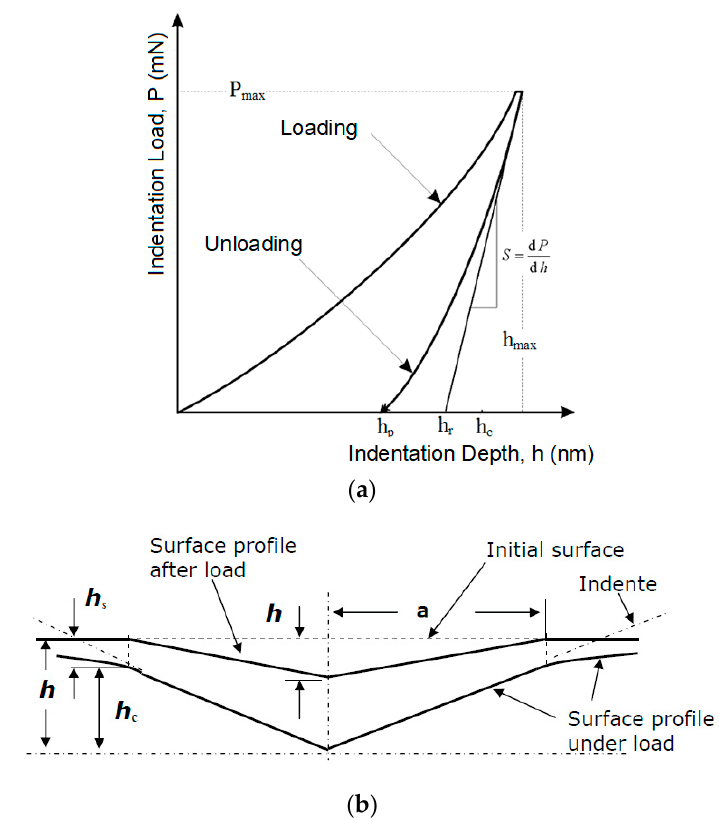
Figure 4. ( a ) Load–displacement curve, showing the values used in the Oliver and Pharr method [26]; ( b ) cross-section of an indentation [26].